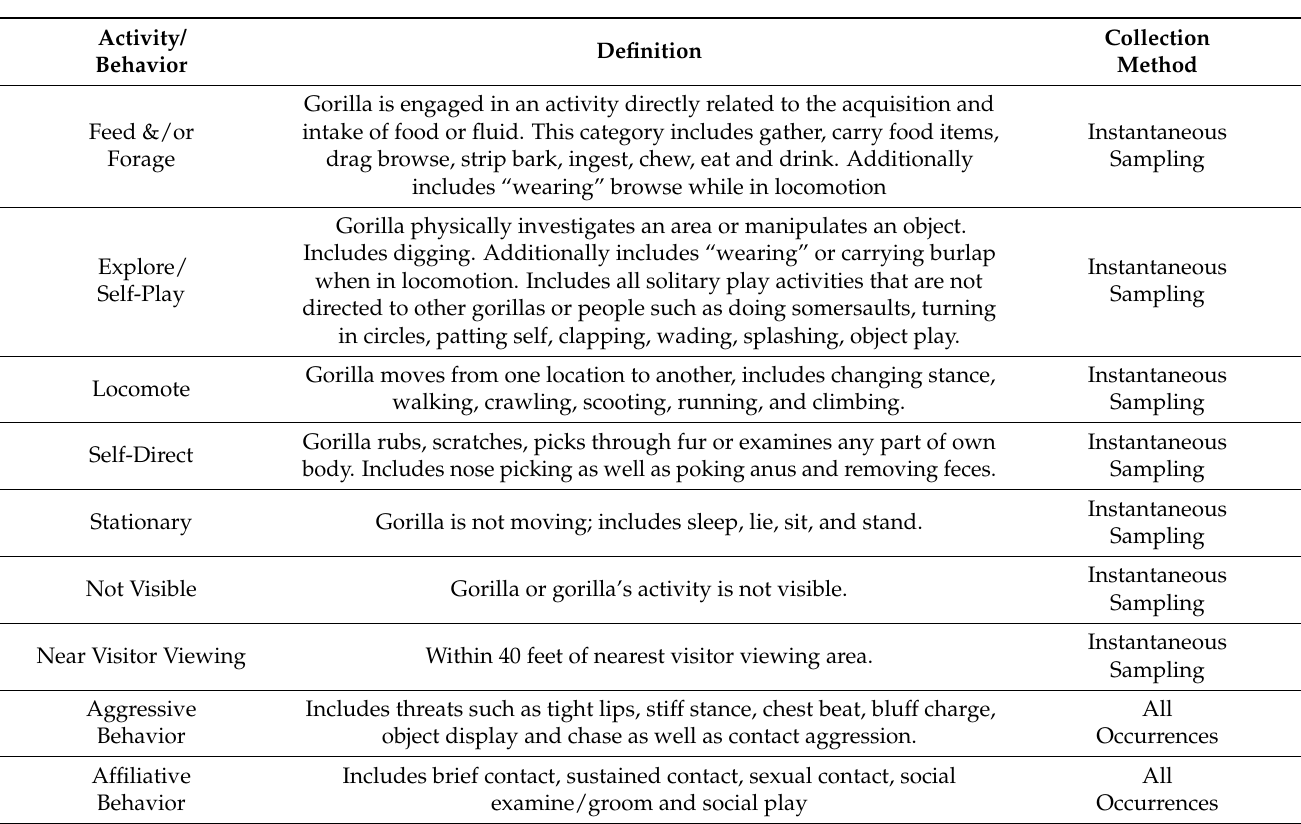
Table 2. Ethogram of gorilla activities, location, and occurrences of social